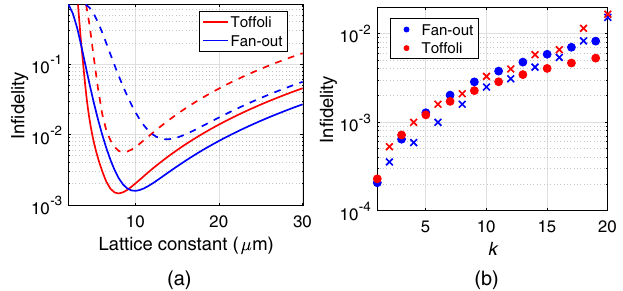
dark state, avoid population leakage to nonresonant Rydberg pairs, and keep the associated unwanted phases small; see Appendix D. The infidelities shown with cross symbols in Fig. 4(b) are obtained with the optimized dynamical parameters 16 kHz < Ω t = 2 π < 8 MHz, Ω = 2 π ¼ 16 MHz and a lattice constant of c r ¼ 8 μ m for the Toffoli gate, and 1 MHz < Ω = 2 π < t 8 MHz, Ω = 2 π ¼ 16 MHz and 8 μ m < r < 10 μ m for c the fan-out gate. Following the parameter optimization, Fig. 4 shows that the dark-state multiqubit gates can be realized for up to k ¼ 20 atoms with less than 1% errors, making them suited for entanglement generation schemes and surface-code error correction [41]. The adiabatic dark-state evolution improves the fidelity compared with the blockade scheme by reducing different rotation errors and by decoupling the motional degrees of freedom; see Appendix E. The conven- tional blockade scheme entails a blockade leakage error E r 3 , while the dark-state approach suppresses rotation =E errors in Eqs. (7) and (8) by a factor ð E r 3 Þ ¼ adi ð Ω 2 t = 160 B 2 1 Þ ; see Appendix B. Also, in the blockade schemes, the control-target interaction results in level shifts that enhance off-resonant excitation of neighbor- ing Rydberg pairs with resulting gate errors E blo r 2 ;t ¼ P k k ð 1 = 2 k þ 1 Þ½ Þf Ω 2 t = ½ 4 ð δ (cid:3) jB ct Þ 2 (cid:2)g þ ð Ω 2 t = 4 δ 2 Þ(cid:2) in the j ¼ 1 ð j P k k Toffoli gate and E blo r ¼ ð 1 = 2 k þ 1 Þ Þf½ j Ω 2 t = 4 ð δ (cid:3) j ¼ 1 ð j 2 ;t ð j − 1 Þ D tt Þ 2 (cid:2) þ ½ j Ω 2 t = 4 ð δ (cid:3) B ct Þ 2 (cid:2)g in the fan-out gate. In comparison with the errors of the dark-state gates, shown in Fig. 4, the blockade Toffoli scheme, working with simultaneous pulses, results in the error range of 0 . 02 < E < 0 . 09 for 3 < k < 24 [6] and in the range 0 . 015 < E < 0 . 35 for the fan-out gate for the same range of k numbers. Comparing with the filled circles